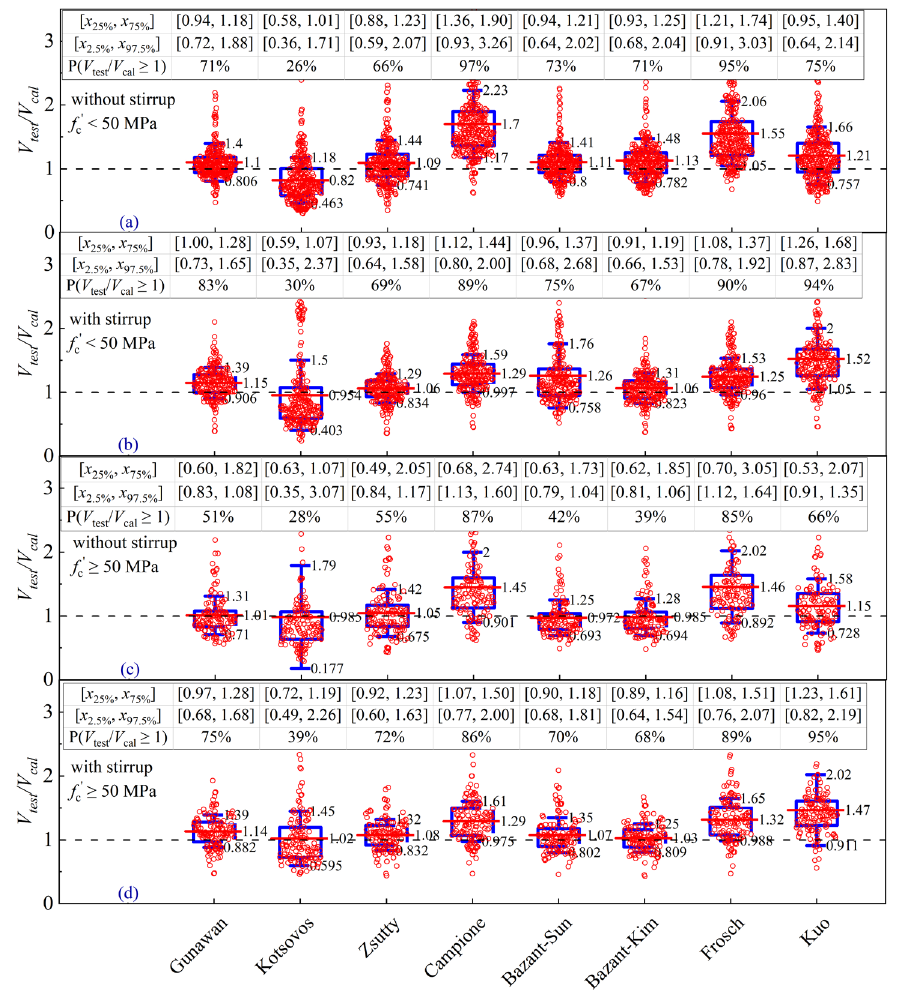
Figure 14. Researchers: prediction results for beams without stirrup versus ( a ) normal concrete strength and ( c ) high concrete strength and for beams with stirrup versus ( b ) normal concrete strength and ( d ) high concrete strength.